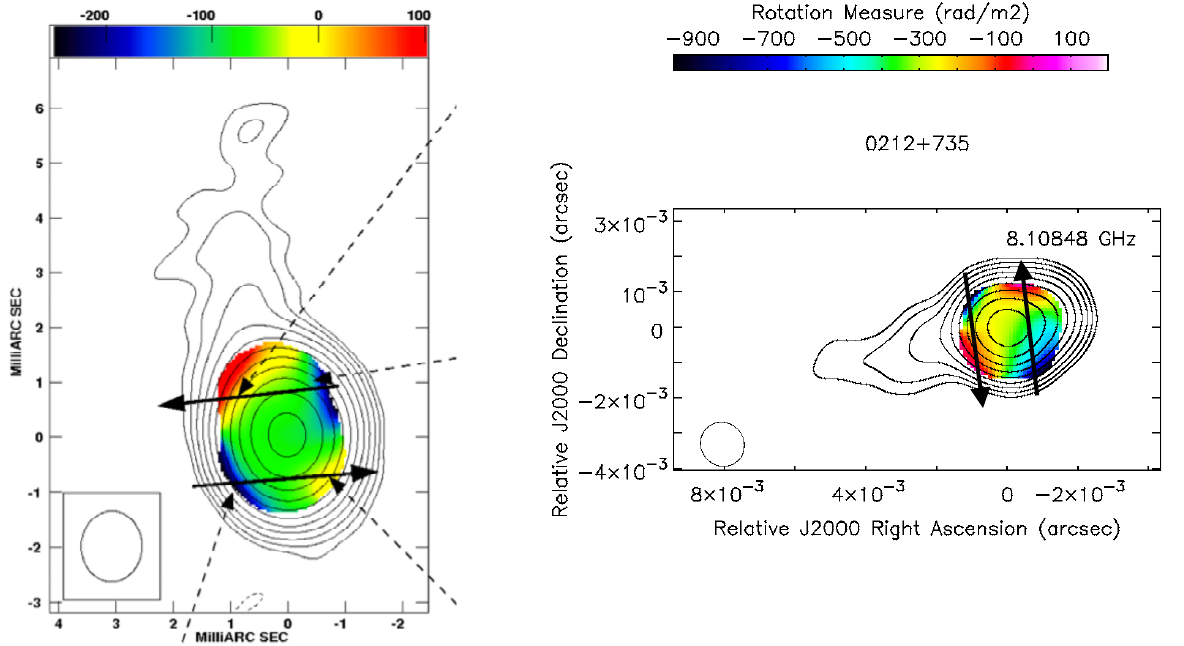
Figure 2. Two examples of reversals in the directions of transverse RM gradients observed across the core and inner jet. The left part of the figure shows the RM map of 0716+714, adapted from Figure 3 of [29], and the right part of the figure the RM map of 0212+735, adapted from [25]. The sizes of the Gaussian restoring beams are shown by the ellipses in the bottom left-hand corners of the